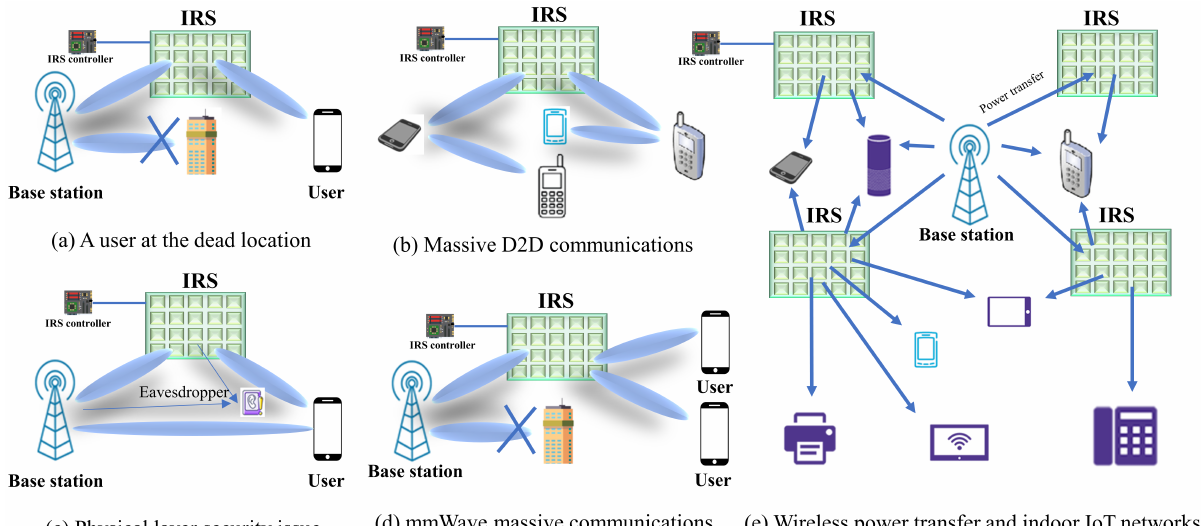
Figure 10. IRS-aided wireless communication